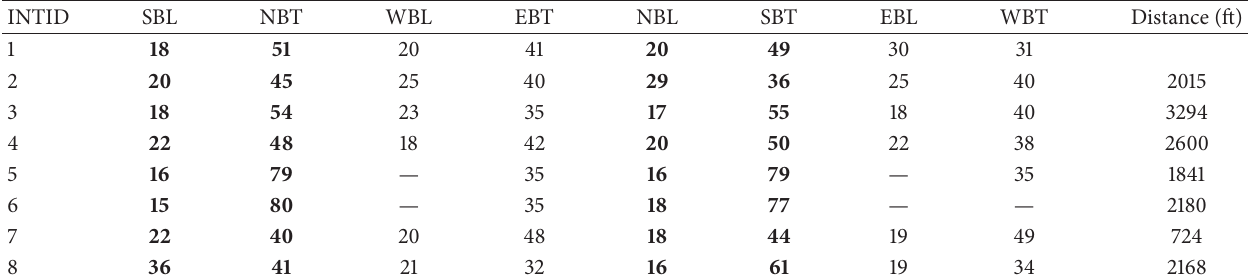
Table 8: Phase splits in the initial signal timing plan of Kietzke Lane (2nd Street → Peckham Lane).